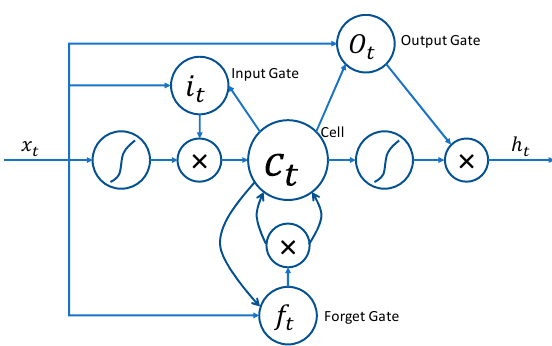
Figure 5. A Single long short-term memory (LSTM) unit. Here, c t , i t , f t , and o t represents cell, input gate, forget gate, and output gate,